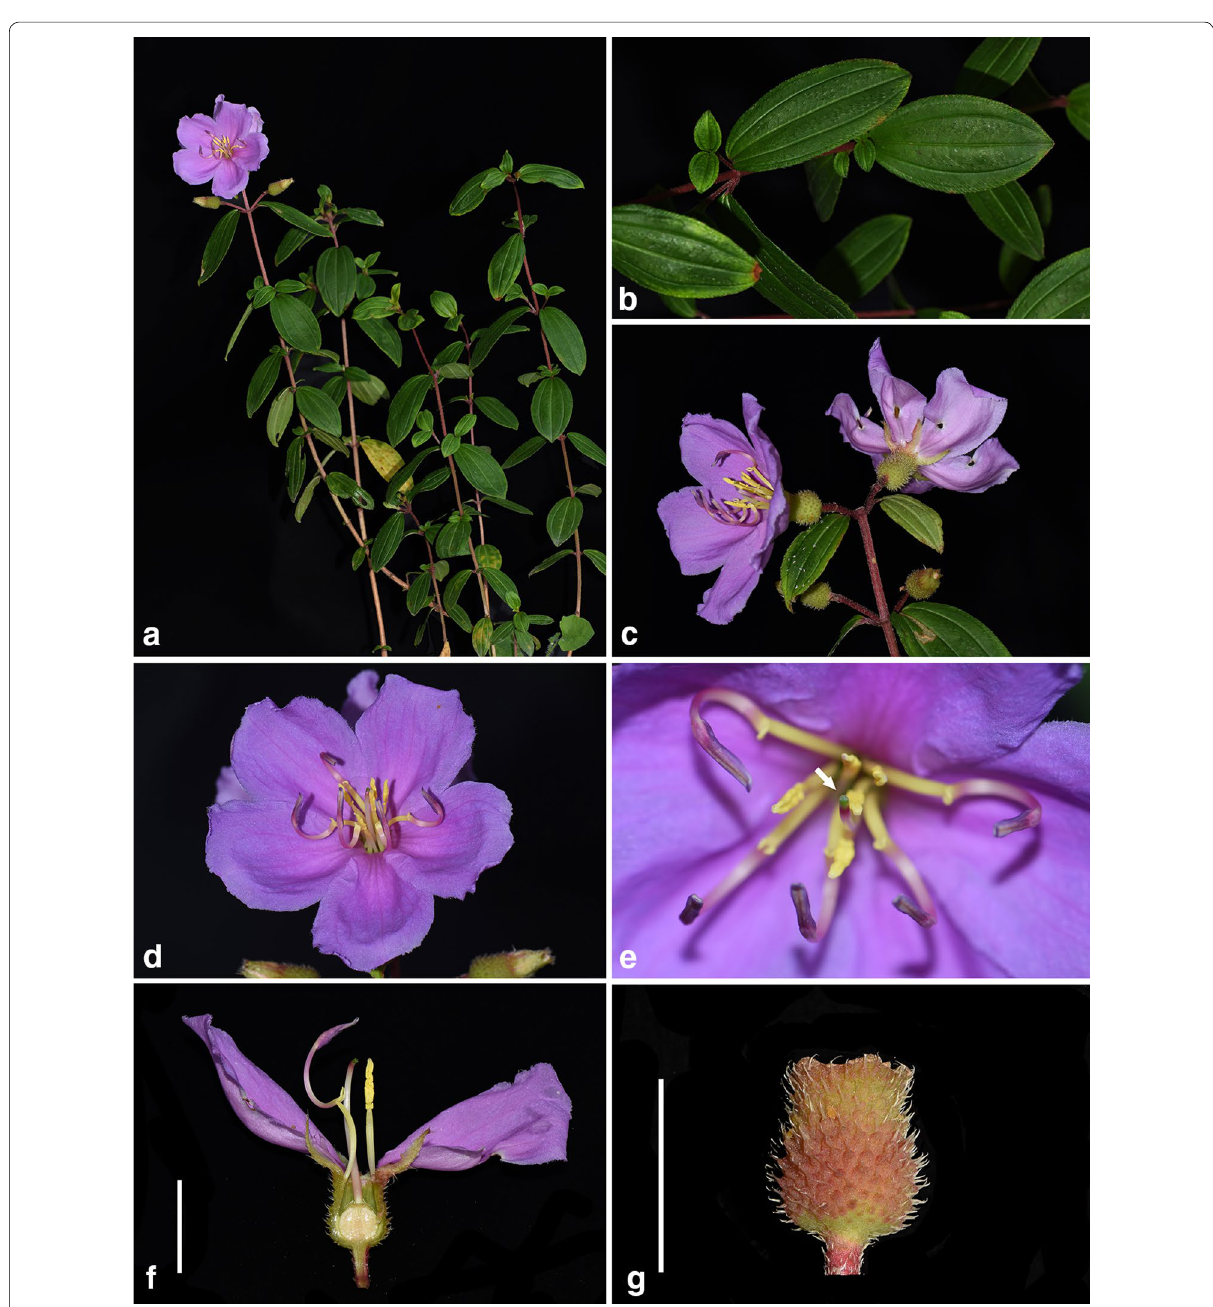
Fig. 7 Melastoma kudoi Sasaki. a Habit; b leaves; c inflorescence; d flower; e detail of flower, arrow indicated the position of stigma; f longitudinal section of a flower, scale bar 10 mm; g young fruit showing the dense, spreading, basally enlarged hairs, scale bar 10